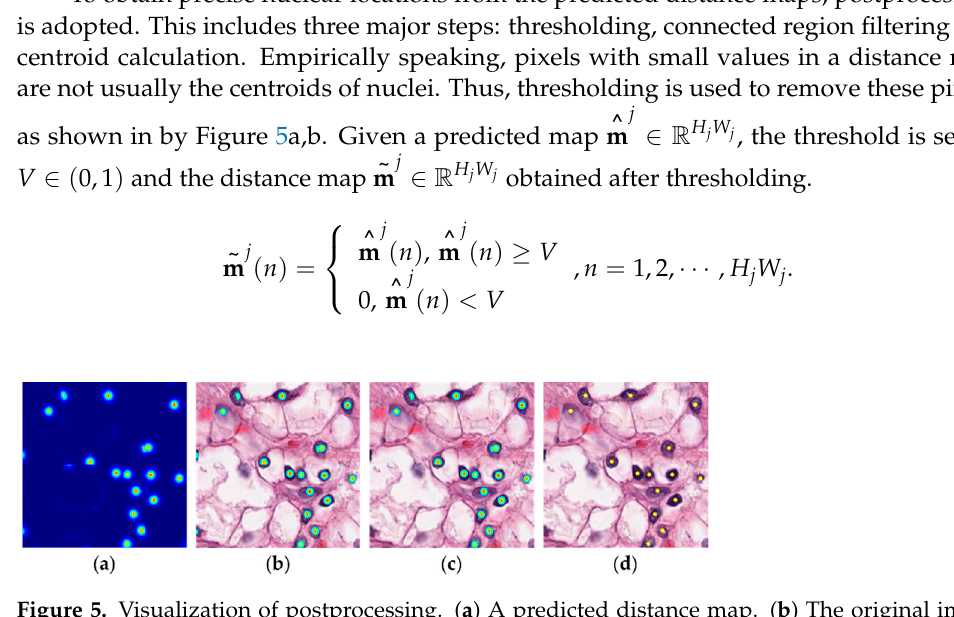
Figure 5. Visualization of postprocessing. ( a ) A predicted distance map. ( b ) The original image overlaid with the distance map after thresholding. ( c ) The original image overlaid with the distance map after connected region filtering. ( d ) The original image overlaid with centroids (yellow dots) in connected regions, regarded as the estimated nuclear locations. Algorithm 1 Implementation details of the nuclear localizer.